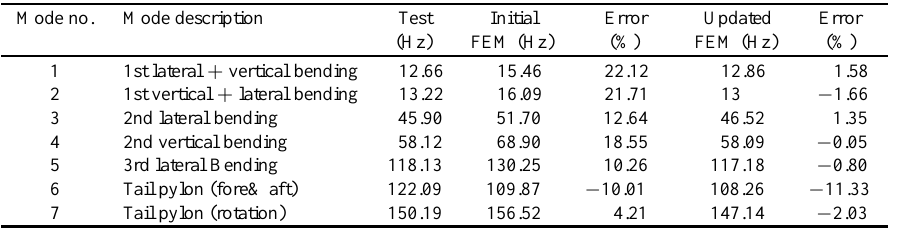
Table 1 Comparisons of analytical and predicted natural frequencies (Hz) and errors (%)